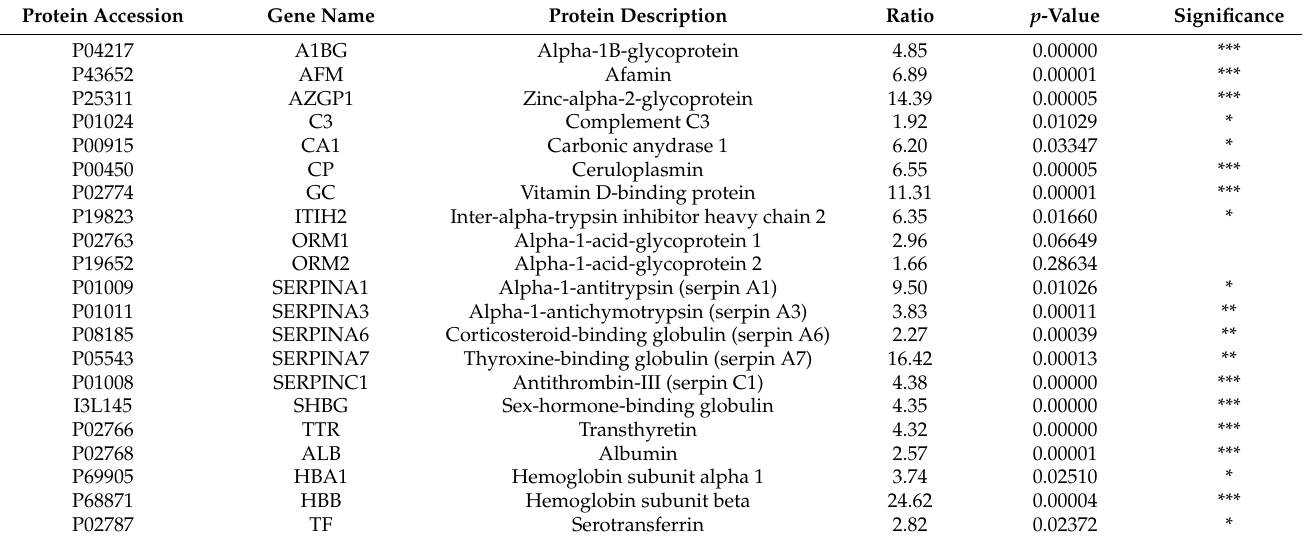
Table 2. Validation study by targeted proteomics of 21 urinary proteins in women with and without preeclampsia. Protein Accession